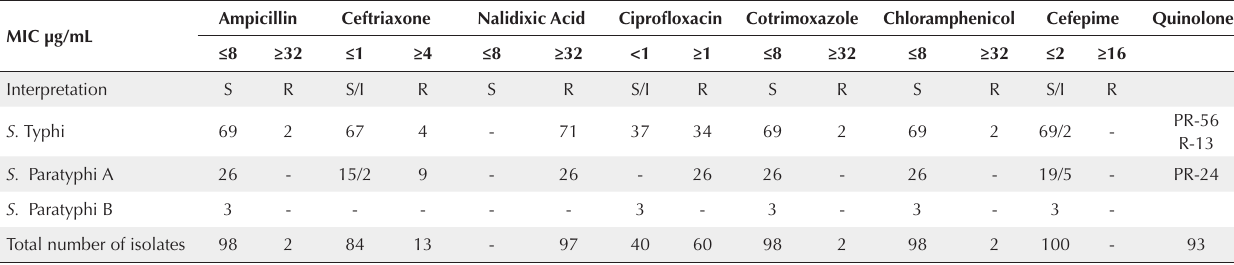
Table 2. Resistance patterns of Salmonella Typhi and Salmonella Paratyphi A and